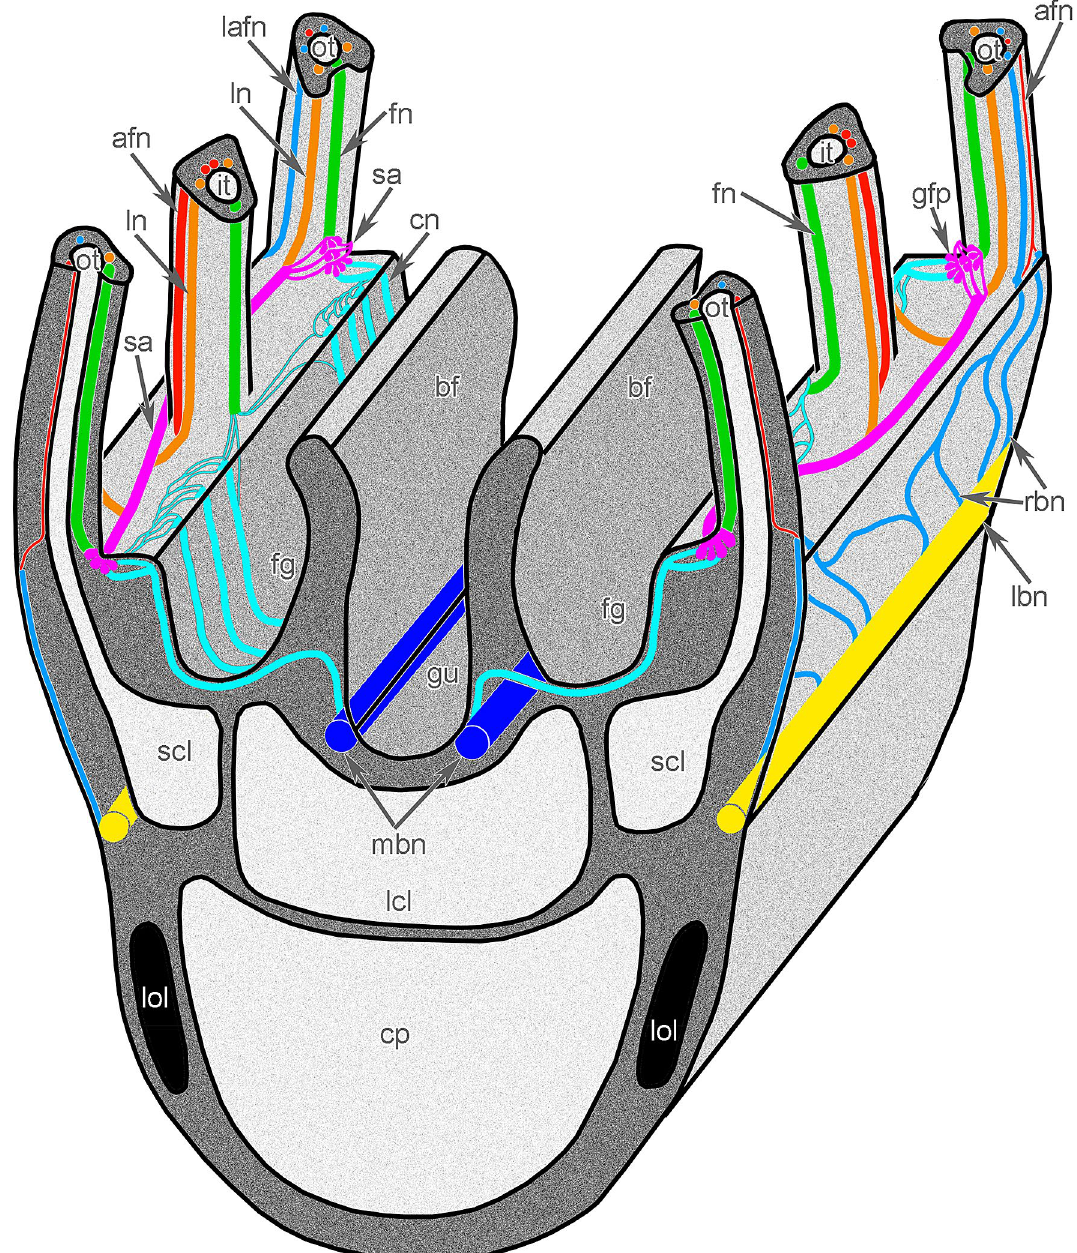
Figure 6. Scheme of innervation of lateral arm of the lophophore of Coptothyris grayi . Abbreviations: afn— abfrontal tentacle nerve; bf—brachial fold; cn—cross nerve; cp—coelomic pouch; fg—food groove; fn—frontal tentacle nerve; gfp—groups of frontal perikarya; gu—gutter; it—inner tentacle; lafn—lateroabfrontal tentacle nerve; lbn—lower brachial nerve; lcl—large canal of the lophophoral coelom; ln—lateral tentacle nerve; lol— lamella of loop of the lophophore brachidium; mbn—main brachial nerve; ot—outer tentacle; rbn—radial brachial nerves; sa—second accessory brachial nerve; scl—small canal of the lophophoral